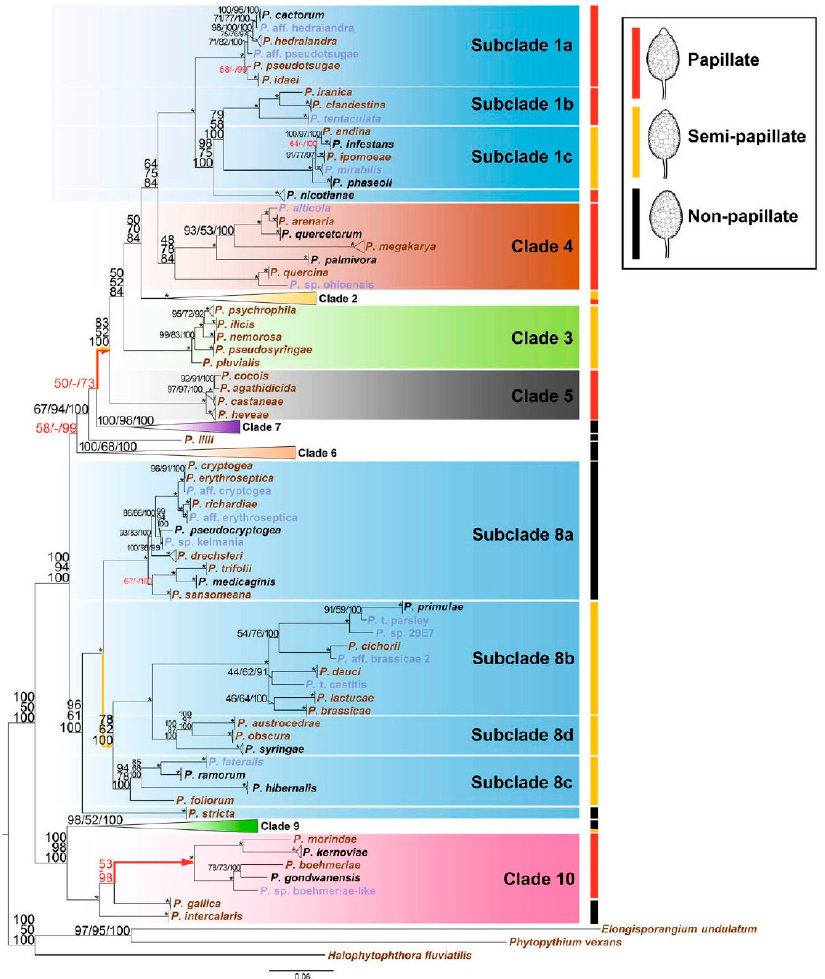
Figure 1. Phylogenetic tree showing P. sansomeana ’s position in subclade 8a based on seven genetic markers including: 60S Ribosomal protein L10 (60S); beta-tubulin (Btub); elongation factor 1 alpha (EF1 α ); enolase (Enl); heat shock protein 90 (HSP90); 28S ribosomal DNA (28S); and tigA gene fusion protein (TigA). Values at nodes represent bootstrap values for maximum likelihood and maximum parsimony, and Bayesian posterior probabilities in percentage. Asterisks represent 100% support between all three analyses. Figure reproduced from Yang et al. [15] under Creative Commons CC BY license from Springer Nature.